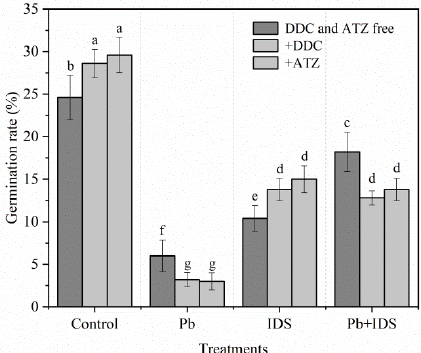
Figure 6. Effects of DDC and ATZ on the germination of maize seeds treated with distilled water, IDS, Pb, or Pb+IDS. Maize seeds treated with distilled water (control), Pb (20 mmol·dm −3 PbCl 2 ), IDS (100 mmol·dm −3 ), or Pb+IDS were further incubated with DDC or ATZ for 1 d. Error bars represent the standard deviation of the mean ( n = 5). Means associated with different letters are significantly different among treatments and time points ( p < 0.05; Duncan’s new multiple range test). Pb, lead; IDS, iminodisuccinic acid; DDC, diethyldithiocarbamic acid; ATZ, aminotriazole.